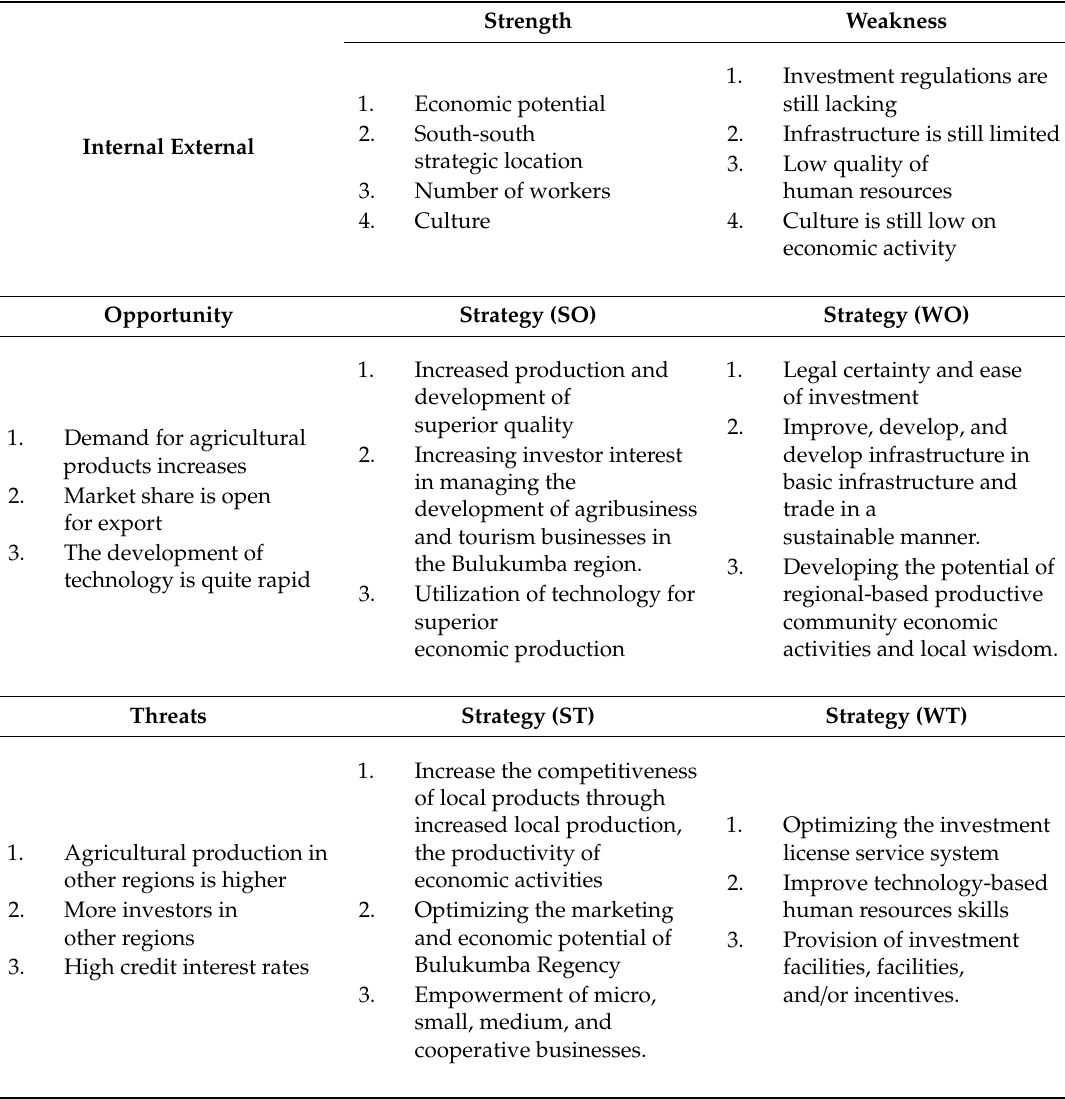
Table 6. SWOT Matrix of Investment Improvement Strategies in Bulukumba